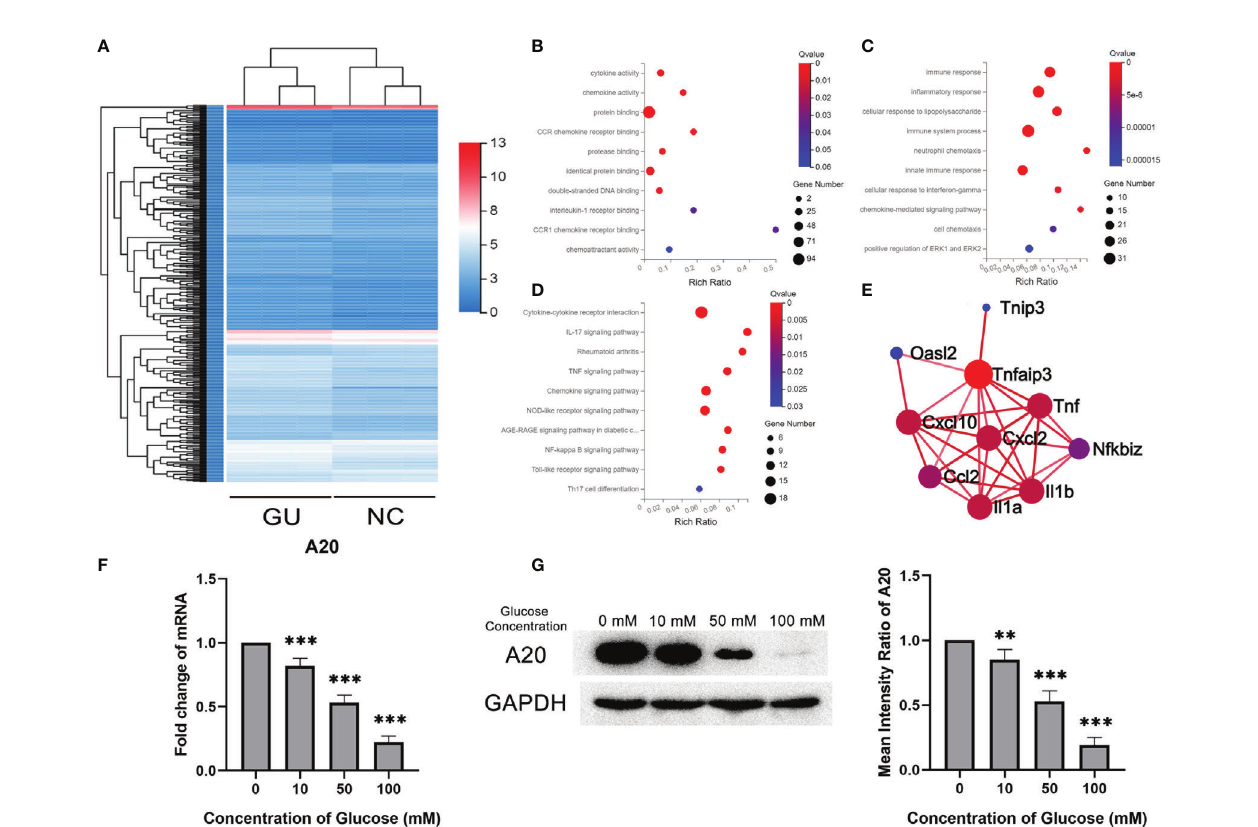
FIGURE 3 | A20 expression of microglia decreased with glucose stimulation. (A) The heatmap of differentially expression gene pro fi les. (B) The top 10 enriched categories of molecular function in GO analysis. (C) The top 10 enriched categories of biological processes in GO analysis. (D) The top 10 enriched signal pathways of KEGG analysis. (E) The PPI network of differentially expressed mRNA. (F) The A20 expression at mRNA level decreased from 10 to 100 mM glucose treatment. (G) The A20 expression at protein levels decreased with 50 and 100 mM glucose treatment. Values are presented as the mean ± SD. ** indicates P < 0.01, and *** indicates P <